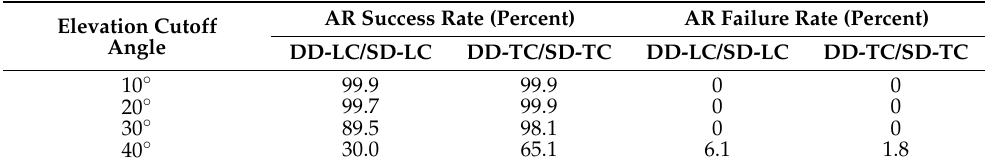
Table 4. The AR success and failure rates of the DD-LC, DD-TC, SD-LC, and SD-TC models under different elevation cutoff angles in the single-epoch solution.